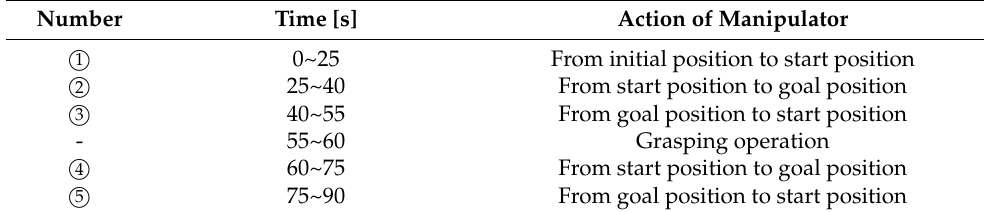
Figure 7. The process of grasping an object. Table 4. Time process of grasping